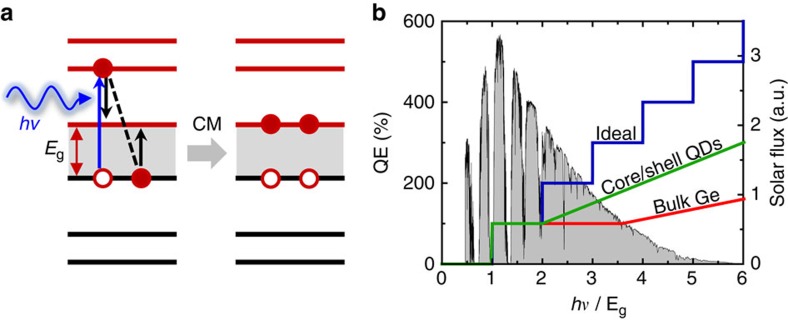
CM and its characteristics.(a) Absorption of a photon with a sufficiently high energy (hv) generates a hot carrier, which can excite an additional e–h pair via an impact-ionization-like collision with a valence band electron. As a result, two e–h pairs are produced per single absorbed photon. (b) Comparison of the ideal QE of photon-to-exciton conversion in the energy-conserving limit (blue) with those of bulk germanium (red) and PbSe/CdSe core/shell QDs (green) assuming the same band gap of 0.67 eV, which is equal to Eg of Ge; the Ge and QD data are adopted from refs 4, 6, respectively. Owing to the reduced threshold (ECM), CM in nanomaterials is active over a wider fraction of the solar spectrum (grey shading) than in the bulk.